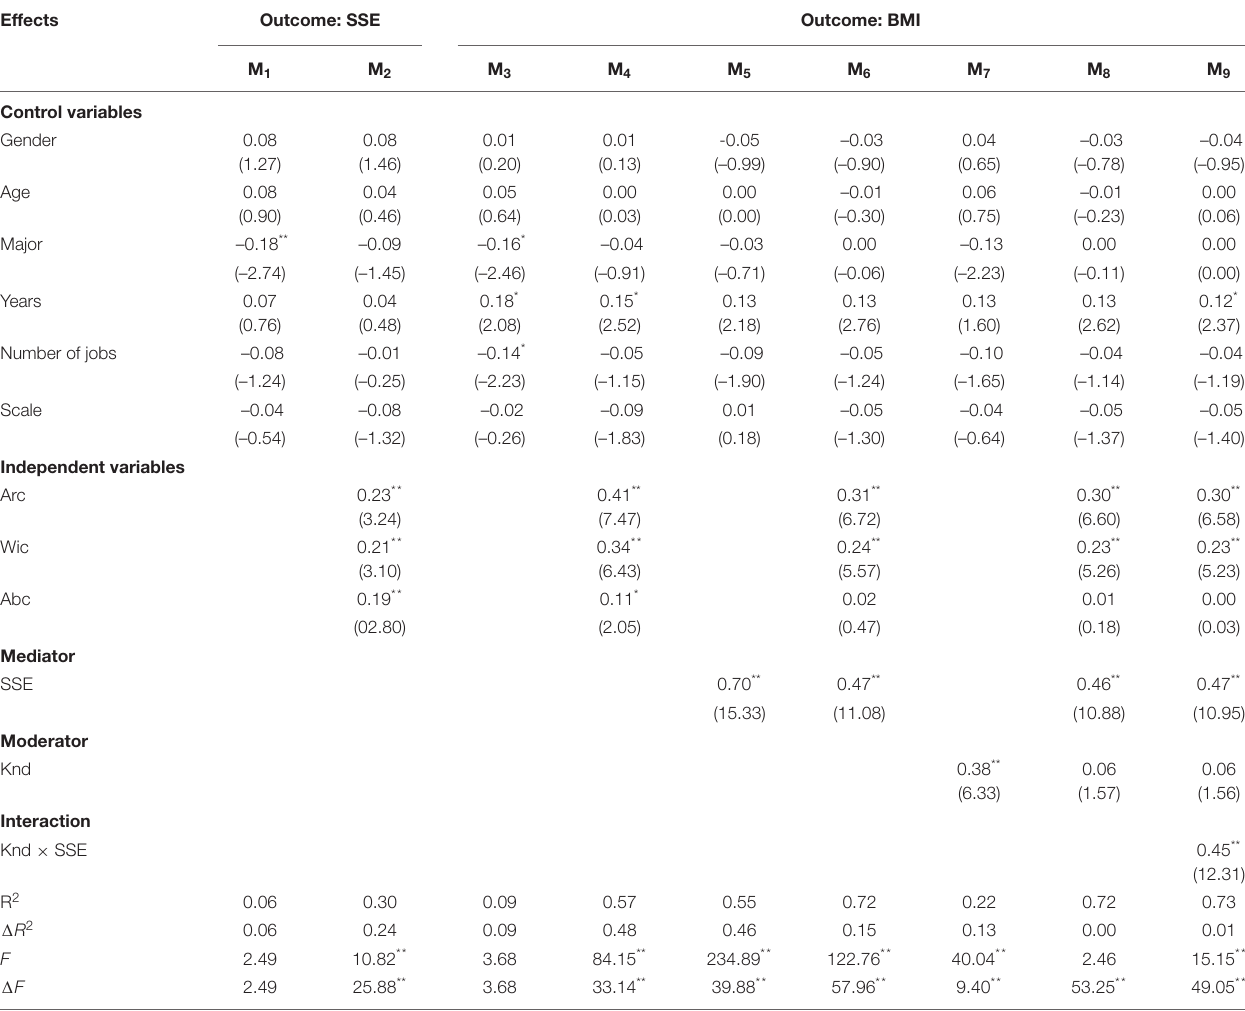
TABLE 4 | Results of hypotheses testing.